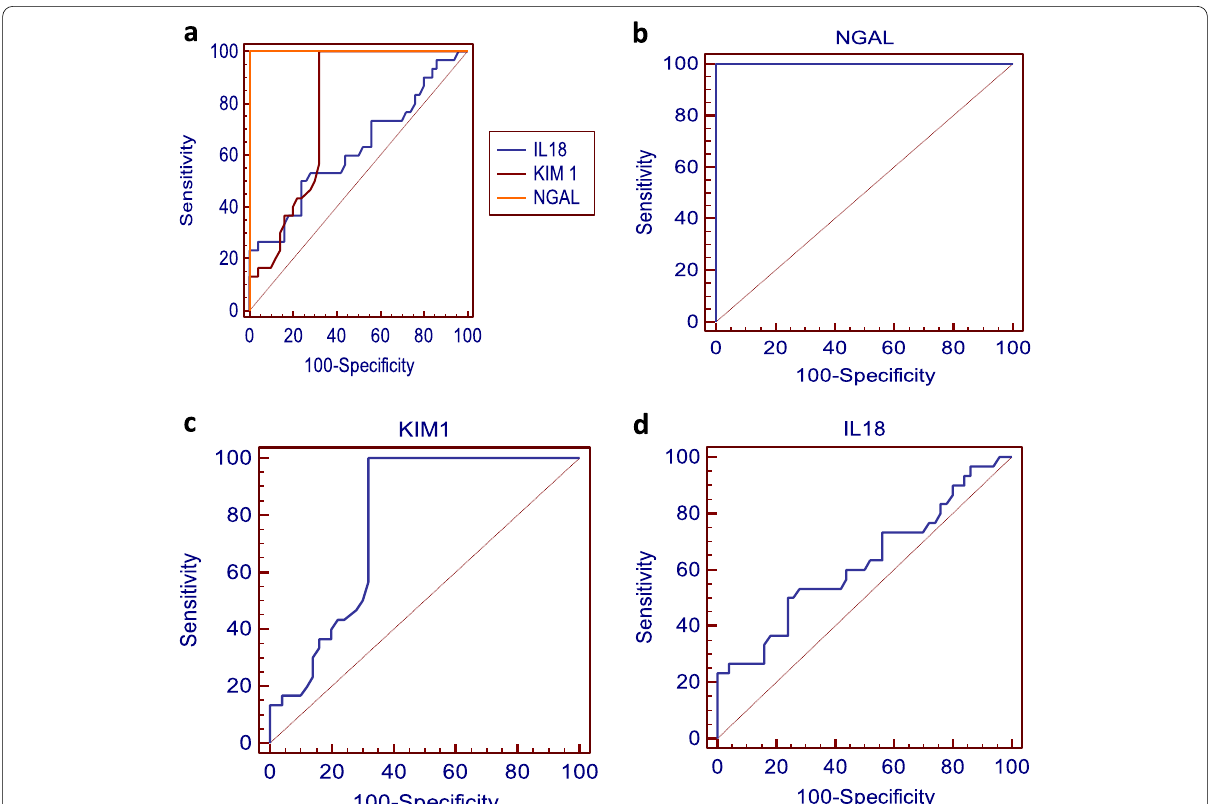
Fig. 4 a ROC curves of urinary IL‑18, urinary NGAL, and urinary KIM‑1 for diagnosis of HRS. b ROC curve of urinary NGAL as a diagnostic tool for HRS. c ROC curve of urinary KIM‑1 as a diagnostic tool for HRS. d ROC curve of urinary IL‑18 as a diagnostic tool for HRS